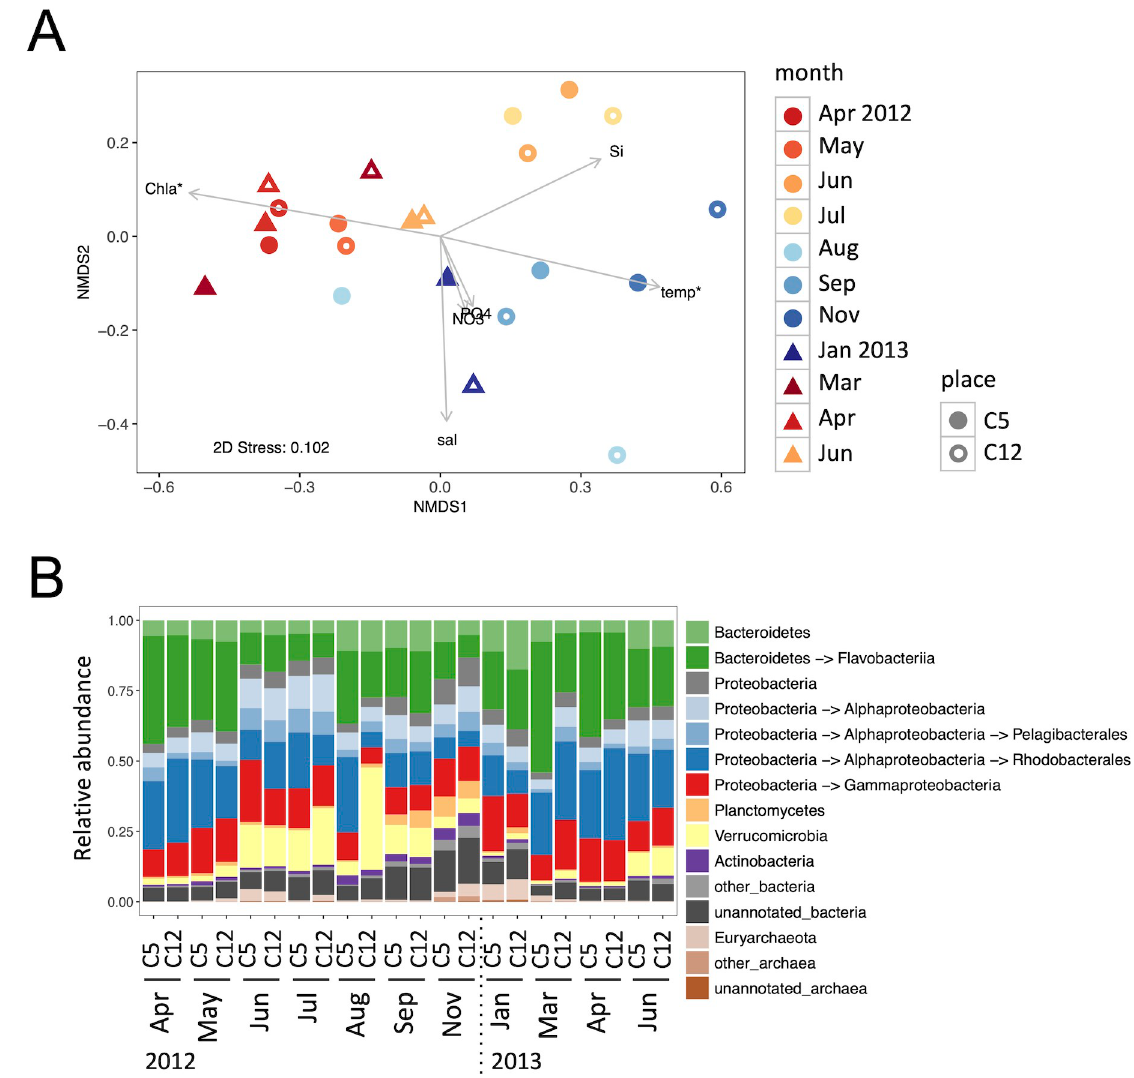
Fig 3. Taxonomic profile of non-cyanobacterial prokaryotic sequences. (A) Nonmetric multidimensional scaling (nMDS) plot of taxonomic composition. Environmental variables are fitted as vectors on the plot; arrow lengths are scaled based on the squared correlation coefficients and the asterisks indicate significant correlations (p < 0.05) with the nMDS ordination. (B) Taxonomic composition using phylum–order rank assignment. Only phyla with max abundance > 0.04 are shown.